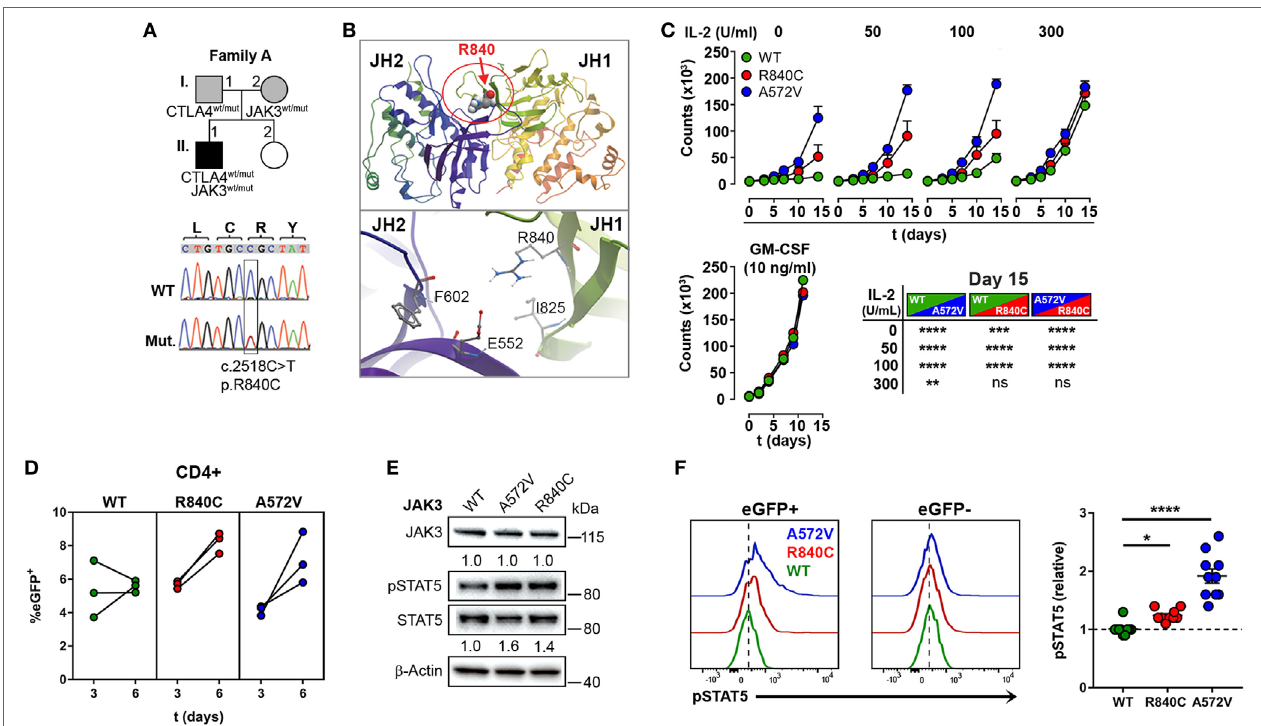
FigUre 3 | A rare gain-of-function mutation in Janus kinase-3 (JAK3). (a) Pedigree of family A showing inheritance of CTLA4 and JAK3 mutations and the confirmation of the JAK3 mutation by Sanger sequencing. Squares: male subjects; circles: female subjects; black-filled symbols: patient with mutation; gray filled symbols: mutation carriers. The position of the JAK3 mutation (Mut.) in cDNA is boxed and the nucleotide and amino acid changes are indicated as c. and p., respectively. WT, wild-type. (b) Structural model of the JAK3 Janus homology domains JH1 and JH2 domains. The position of residue R840 changed by the c.2518C missense mutation to Cysteine is represented as space-filling model and the N-lobe of the Kinase domain is circled (red). The lower panel shows the negatively charged R840 residue and its potential contacts with the positively charged E552 residue. (c) Growth curves of MO7e cells expressing wild type (WT, green color), R840C (red), or A572 (blue) JAK3 cultured w/o or with increasing concentrations of IL-2 or GM-CSF. Significant differences between the growth curves are shown in the lower right panel. Data represent mean ± SEM of three experiments. (D) Percentages of GFP + primary human CD4 + T cells lentivirally transduced with WT (green), R840C (red), or A572V (blue) JAK3 constructs. Cells were activated first with anti-CD3 and anti-CD28 and cultivated from day 3 on in medium containing only IL-2 (2 U/ml). (e) Western blots showing JAK3 and STAT5 expression and STAT5 phosphorylation in MO7e cells expressing WT, A572V, or R840C JAK3 variants after activation with 50 U/ml IL-2 for 10 min. JAK3 expression is normalized to β -Actin; STAT5 phosphorylation is normalized to total STAT5 and compared to JAK3-WT. (F) Representative flow cytometry histograms showing basal STAT5 phosphorylation in CD4 + T cells transduced with JAK3 expression vectors (eGFP + ) compared to the corresponding non-transduced (eGFP − ) cells. Right panel: the plot shows relative pSTAT5 levels calculated for each sample as (MFI of pSTAT5 of eGFP + cells)/(MFI of pSTAT5 of eGFP − cells). Horizontal lines represent mean values. Dots in (D,F) represent individual healthy donor samples transduced with JAK3 expression constructs and are from three and five experiments. **** P ≤ 0.0001; *** P < 0.001; ** P < 0.01; * P ≤ 0.05 [ (c) two-way ANOVA, Tukey’s or (F) one-way ANOVA, Holm–Sidak’s multiple comparisons